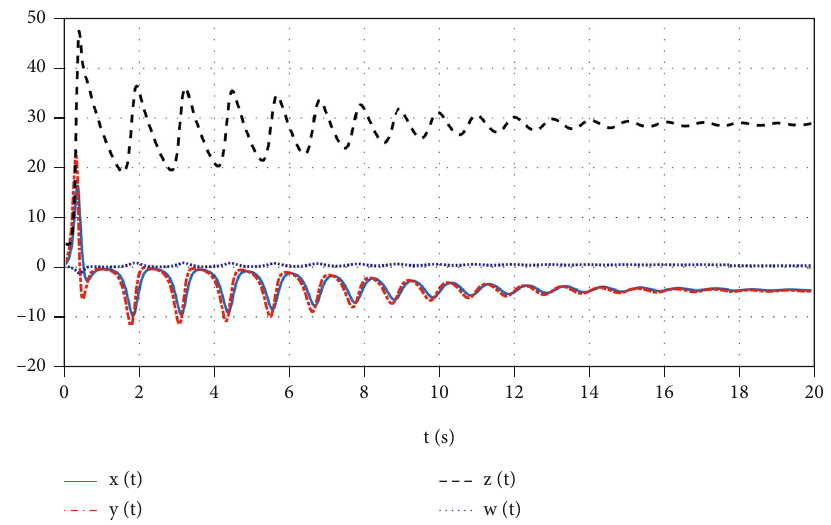
Figure 3: Time series trajectories of the LS system (5) for the fractional order η = 0 : 950